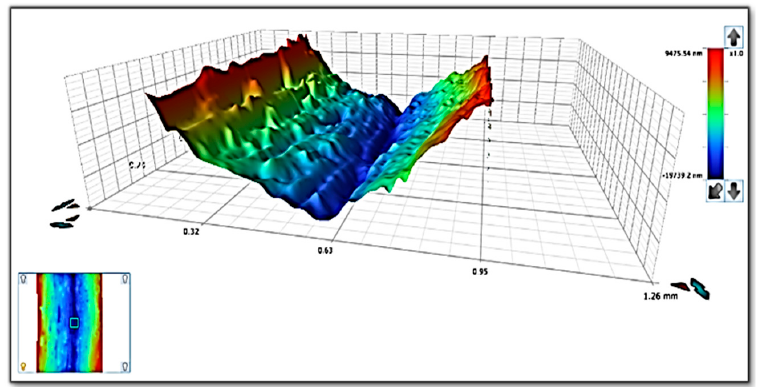
Figure 9. Pin-on-disk wear tracks of NiTec coatings deposited at 11.04 SCFH obtained by laser